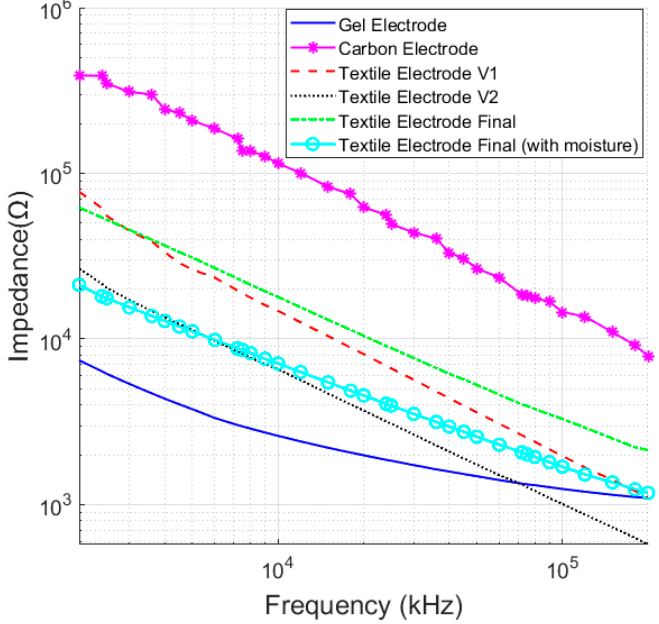
Figure 6. ETI measurement for di ff erent textile electrodes.